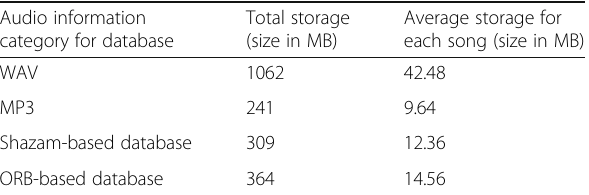
Table 3 Measurement of storage sizes for both algorithms Audio information category for